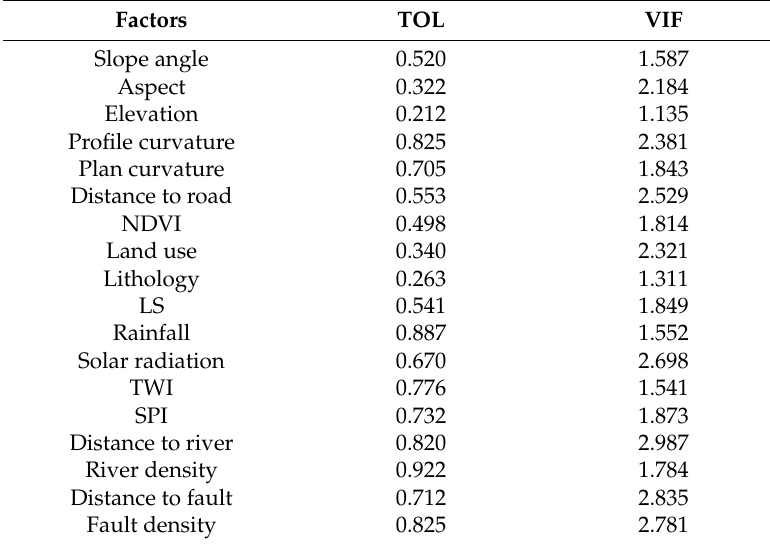
Table 2. The multicollinearity tests of the factors.